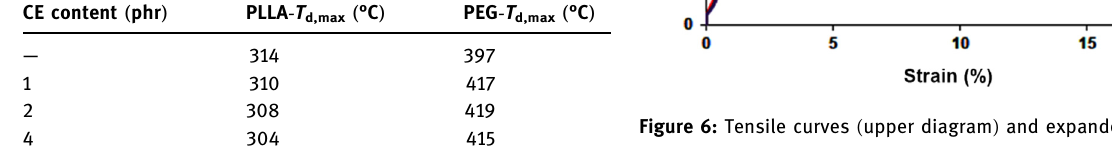
Figure 6: Tensile curves ( upper diagram ) and expanded initial - region ( lower diagram ) of PLLA - PEG - PLLA fi lms without and with